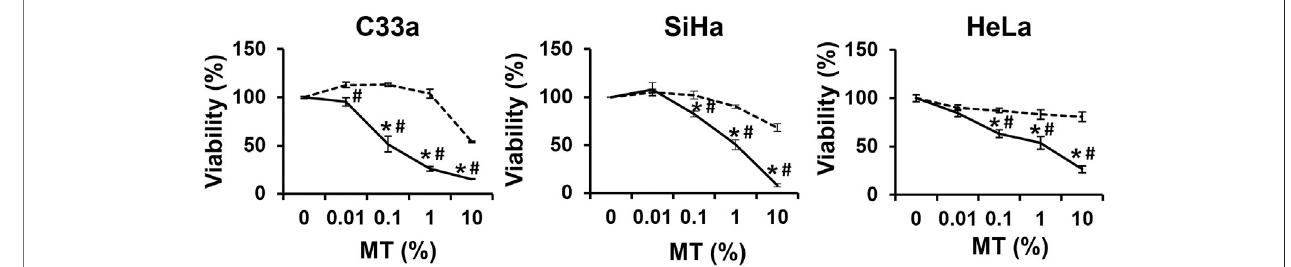
FIGURE 1 | Effect of Berberis aquifolium mother tincture (BAMT) on the viability of different CaCx cell lines. Each panel shows percent cell viability of different HPV negative (C33a) and HPV positive (SiHa and HeLa) CaCx cell lines treated with increasing concentrations (0.01, 0.1, 1 and 10%) of MT of B. aquifolium at 24 h. The cell viability was measured by MTT assay as described in methods. Cells were similarly treated with succussed ethanol strength for MT- 70%) at corresponding concentration of alcohol content in the drug as alcohol/vehicle control. The results are representative of three independent experiments with similar results, data represent mean ± SD with * p values ≤ 0.05 with respect to control. # p values ≤ 0.05 compared to cultures treated with corresponding concentrations of vehicle control. Solid lines represent drug and broken lines represent vehicle